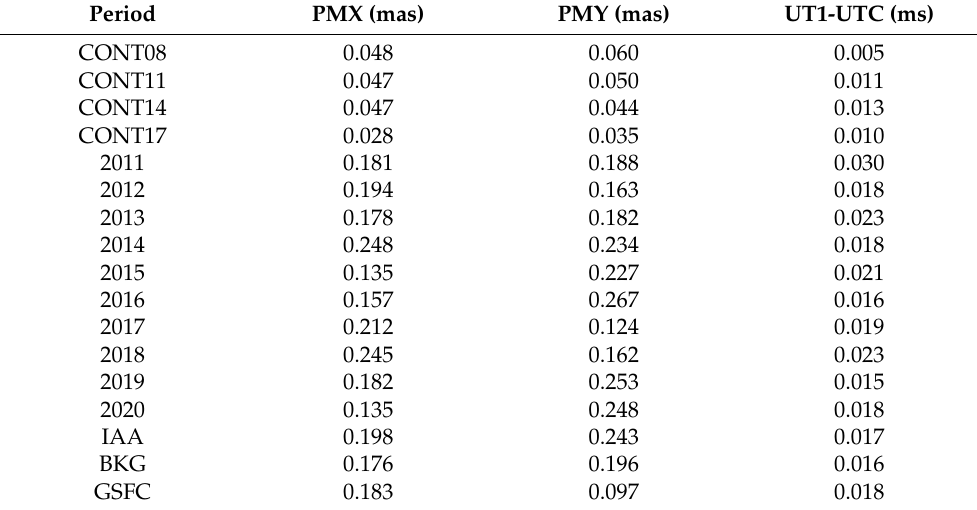
Table 4. RMSE of ERP estimated from experiments. CONT indicates ERP accuracy based on CONT solutions, years indicate ERP accuracy based on IVS-R1/R4 solutions. IAA represents the average accuracy of IVS-R1/R4 based on the institute of applied astronomy (IAA), BKG represents the average accuracy of IVS-R1/R4 based on the federal agency for cartography and geodesy (BKG), GSFC represents the average accuracy of IVS-R1/R4 based on the Goddard space flight center (GSFC). Period PMX (mas) PMY (mas) UT1-UTC (ms) CONT08 0.048 0.060